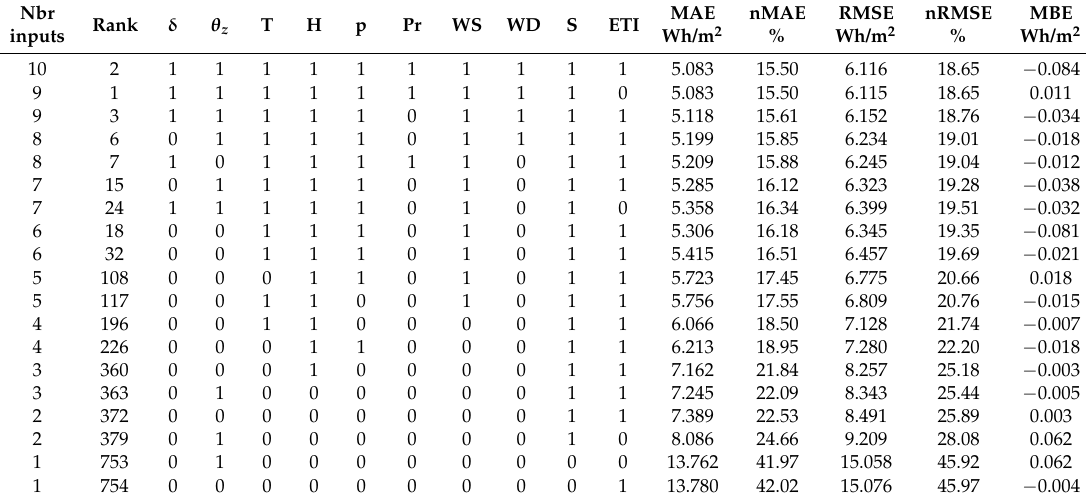
Table 3. Best configurations according to the number of inputs for the Bouzareah site (1 = present data, 0 = absent data).